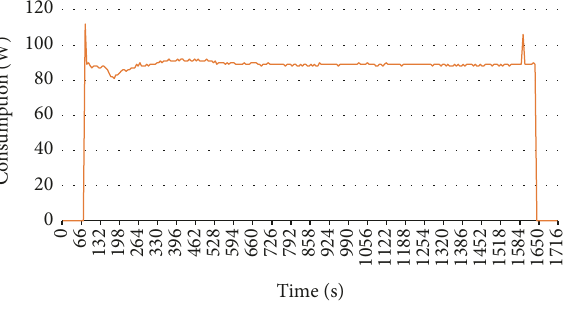
Figure 16: Fridge activation period.